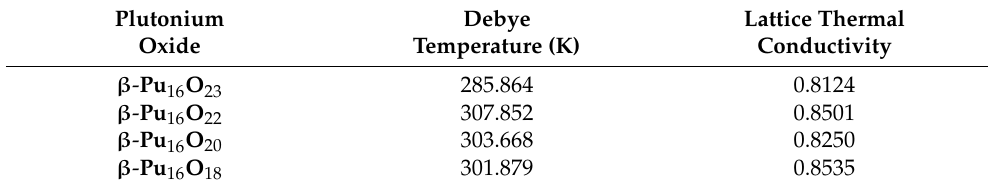
Table 4. Values of the Debye temperature and lattice thermal conductivity of the studied structures.